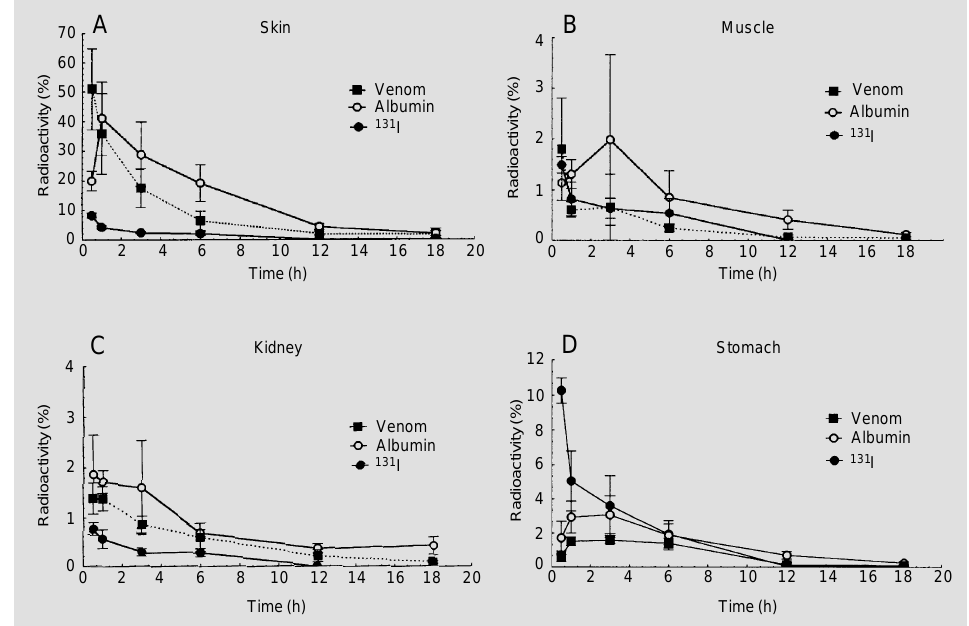
Figure 1 - Distribution of Bo- throps erythromelas venom, al- bumin and iodine in the skin (A), muscle (B), kidneys (C) and stomach (D) of animals submit- ted to perfusion. Radioactivity is reported as percentage of the total injected dose. Data are re- ported as the means ± SD for 3 experiments.